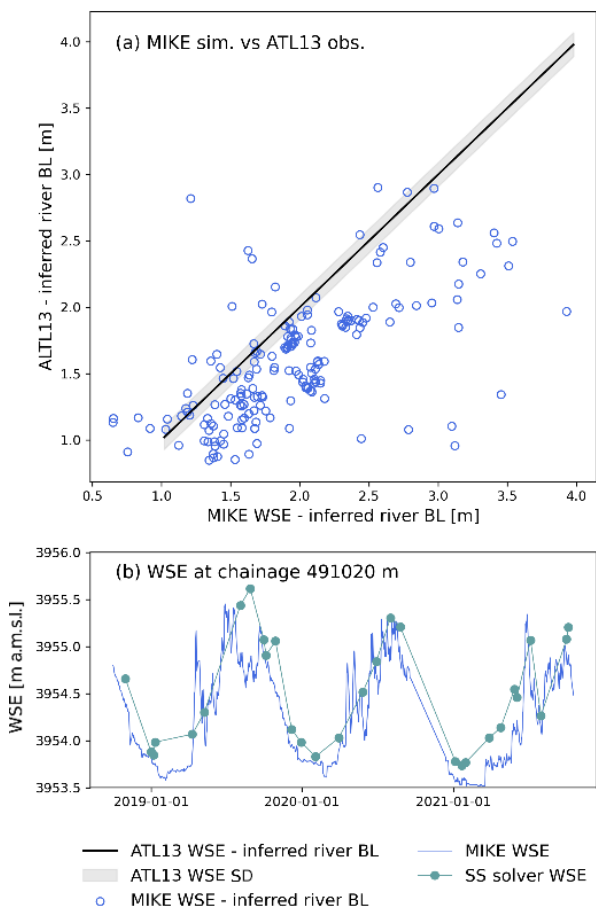
Figure 14. (a) MIKE HYDRO simulated WSE vs. ATL13 WSE minus inferred BL. The shaded area corresponds to the median SD (standard deviation) of the ATL13 observations, as taken from the flag stdev_water_surf. (b) Simulated WSE from the steady-state solver and